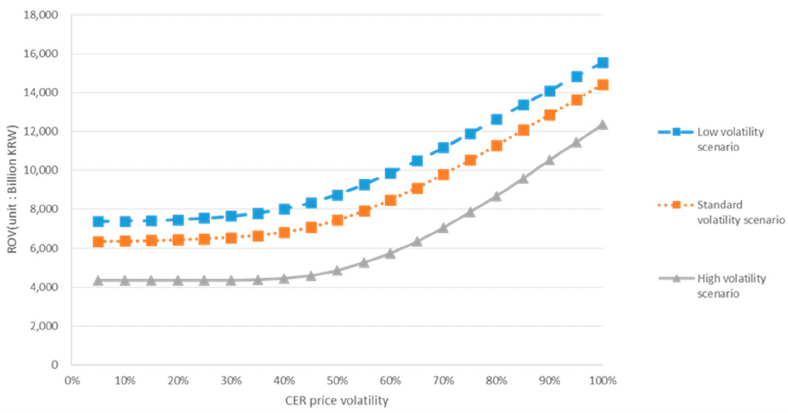
Figure 8. Results of sensitivity analyses on real option value (ROV).